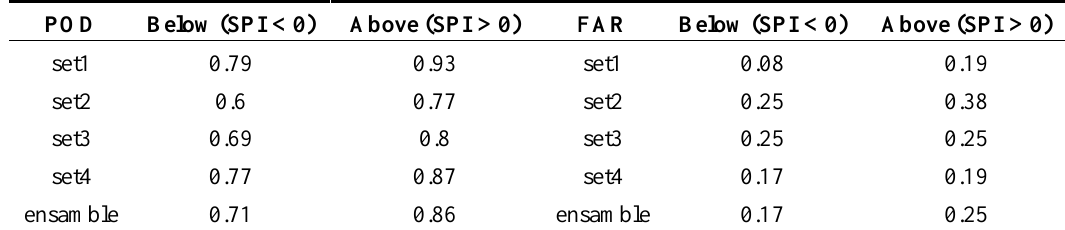
Figure 9. Observed 6-month standardized precipitation index in September and 6 months-standardized precipitation index derived from cross-validation applied to each one of the models detailed in Table 4. The mean (ensemble) of all them is also drawn. Table 5. POD and FAR calculated for the categories “above” (SPI9 > 0) and “below” (SPI9 <